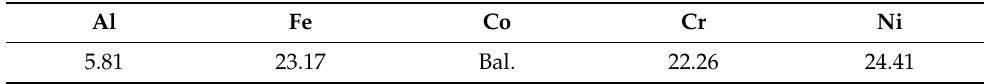
Table 2. Chemical composition of Al 0.5 FeCoCrNi HEA